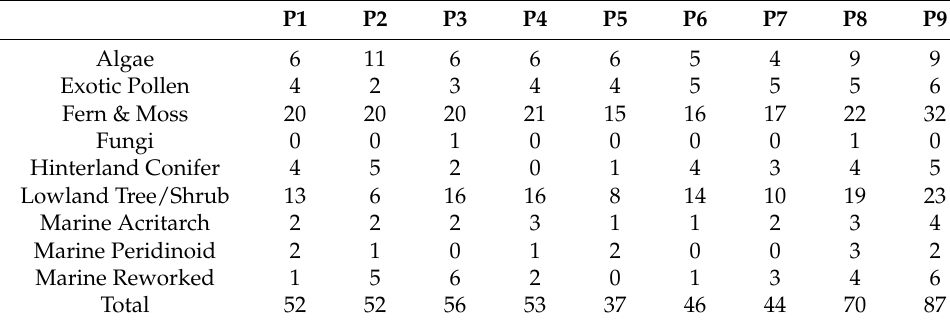
Table 7. Raw taxonomic richness (number of genera) of each paleosol horizon.